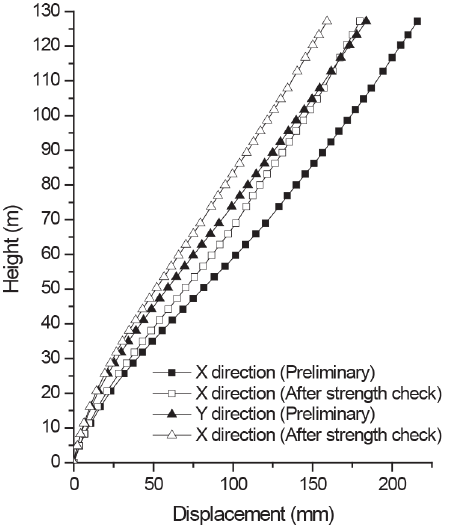
Fig. 8. Distribution of the lateral displacements through the height of the structure